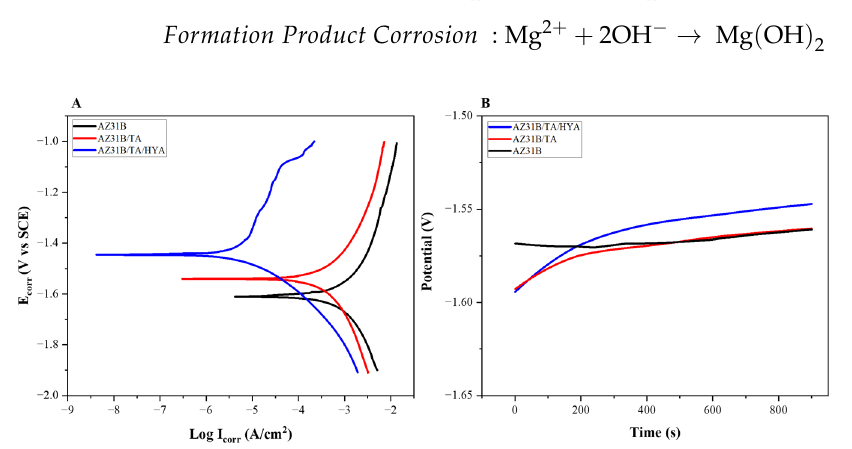
Figure 4. ( A ) Tafel polarization curve on samples AZ31B, AZ31B/TA, and AZ31B/TA/HYA; ( B ) OCP curve on samples AZ31B, AZ31B/TA, and AZ31B/TA/HYA. Table 5. E corr and I corr data on AZ31B, AZ31B/TA, and AZ31B/TA/HYA samples.